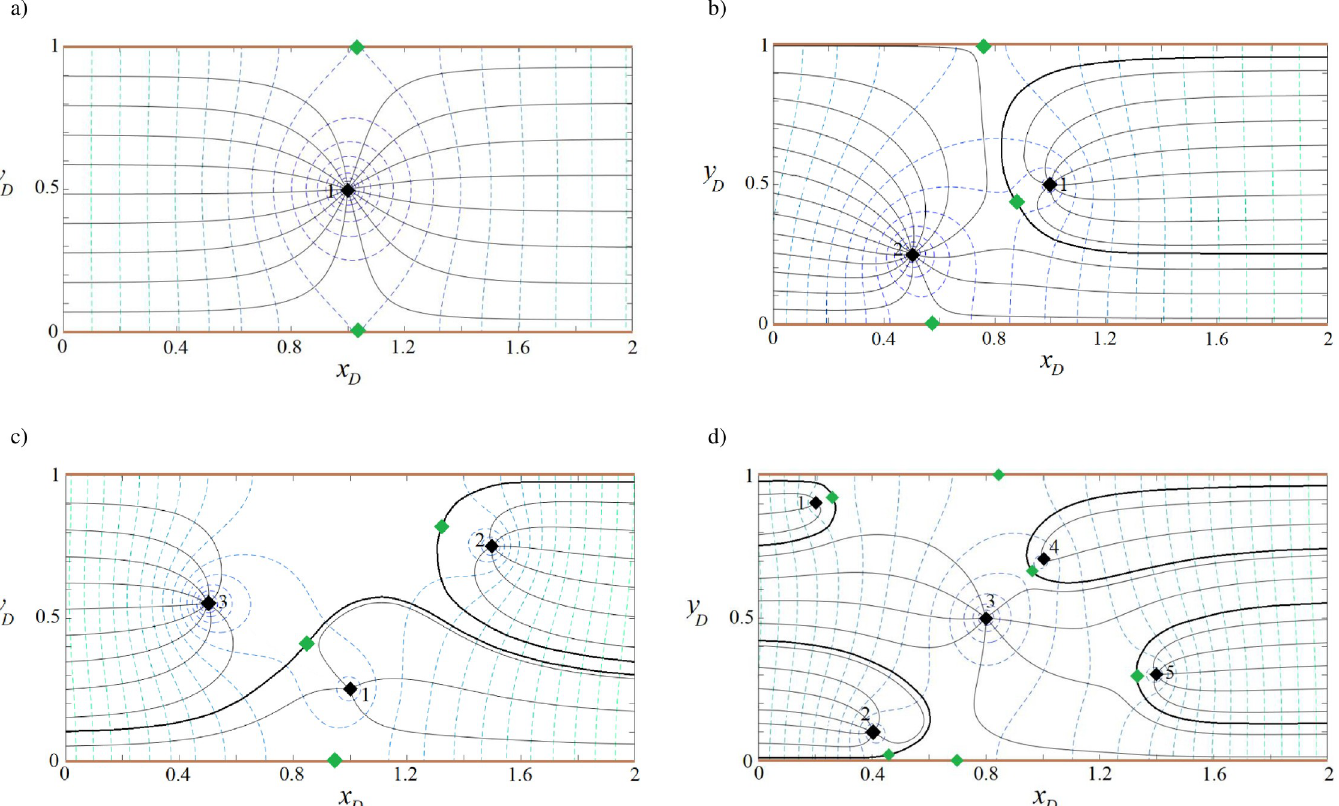
Fig 7. Velocity potential and stream function for one (a), two (b), three (c) and five (d) wells in a strip-shaped aquifer with barrier-barrier boundary conditions.